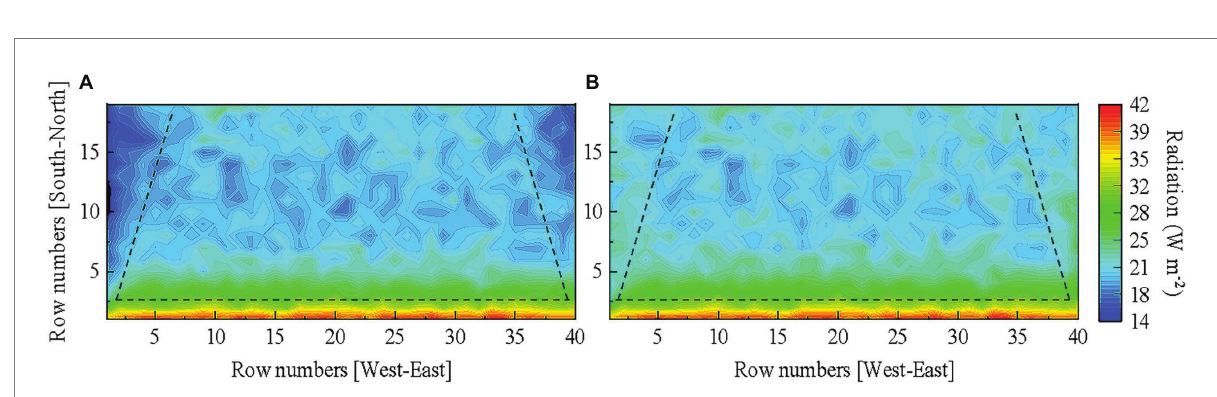
FIGURE 12 Comparison of the horizontal light distribution of tomato canopy (A) without reflective film and (B) under the final reflective film